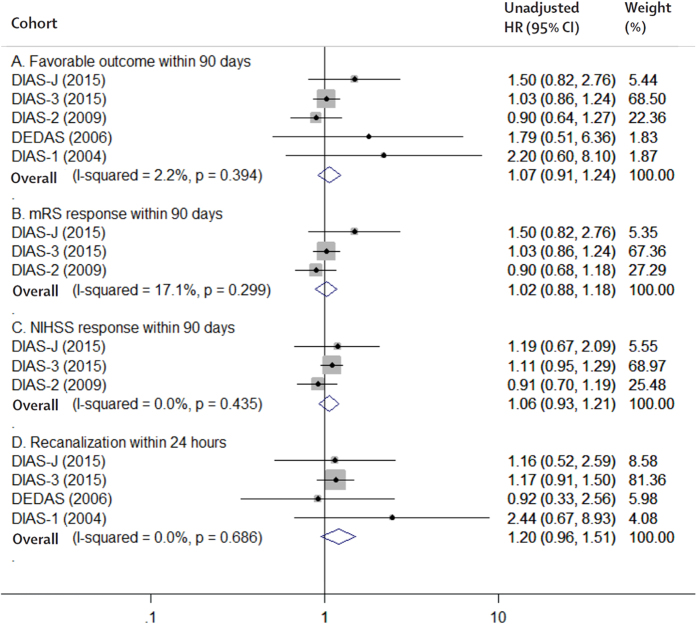
The pooled relative risk of the efficacy outcomes.The diamond indicates the estimated relative risk (95% confidence interval) for all patients.